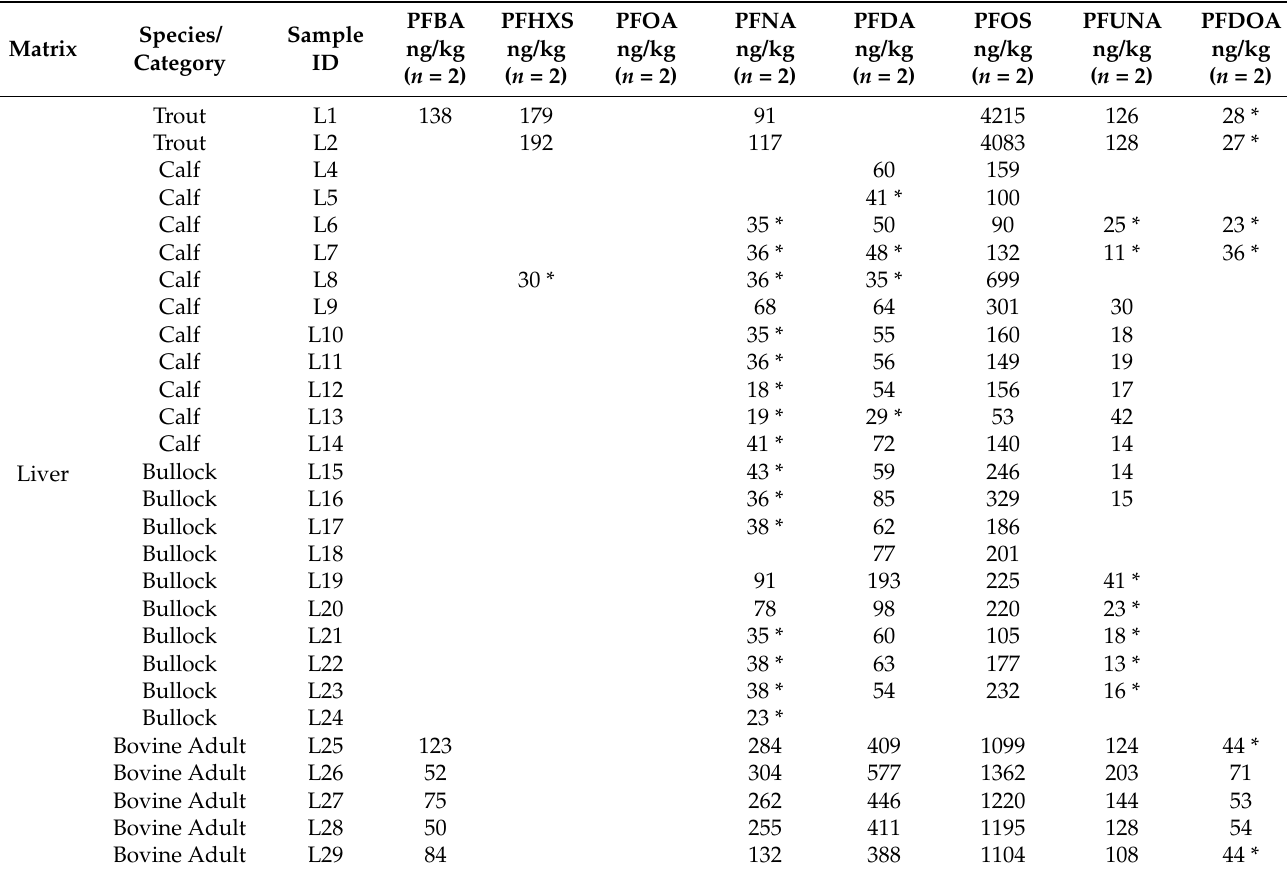
Table 6. PFASs detected in real